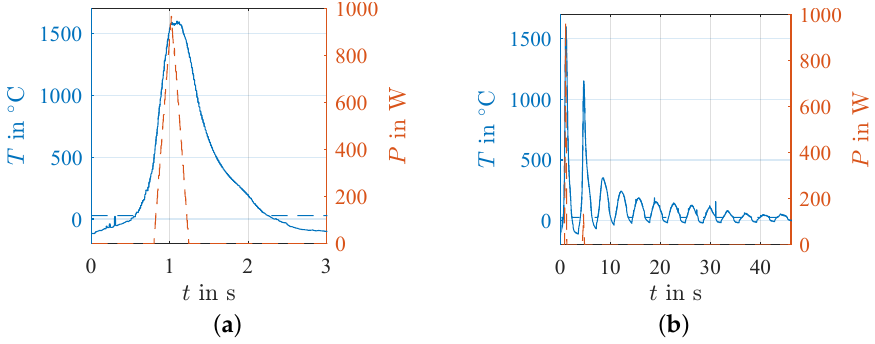
Figure 7. Thermal evolution in one discrete point ( s 1 , s 2 ) = ( 7,2 ) after spatial downsampling. Left axis (blue): Measured temperature (solid line) and corrected temperature values (dashed line). Right axis (red): Corresponding laser power. ( a ) First 3 s of experiment; ( b ) Hole duration of